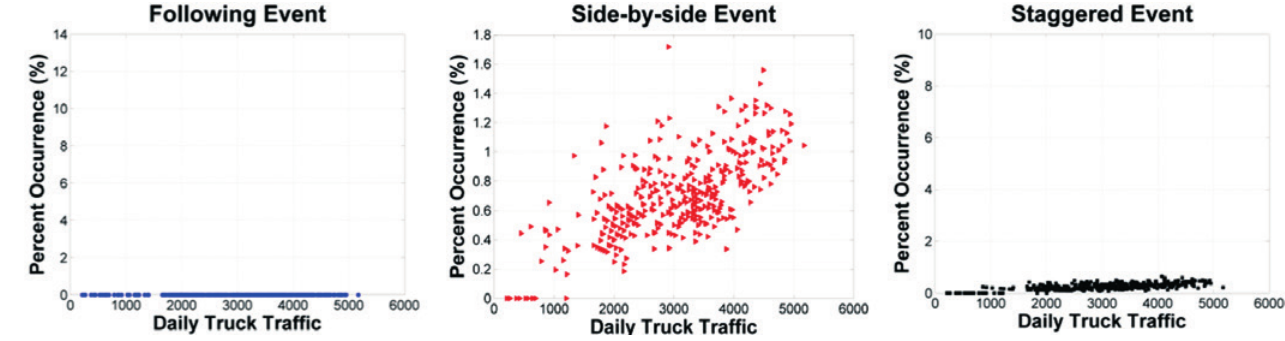
Variation of multiple presence for truck volumes (12.2-m